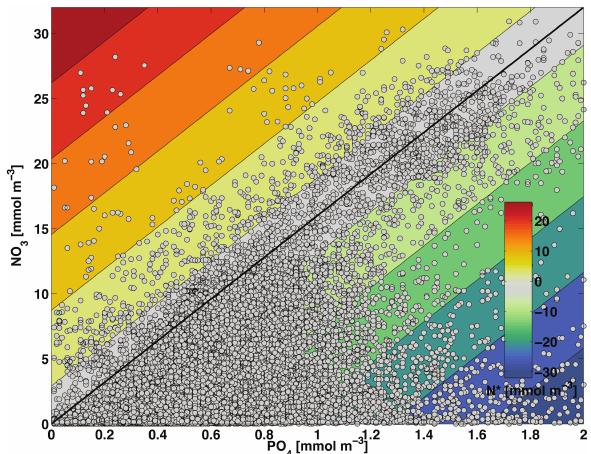
Fig. 4. Location of stations on four transects that were sampled during the OMP program. N* along these transects are shown in Fig. 5.